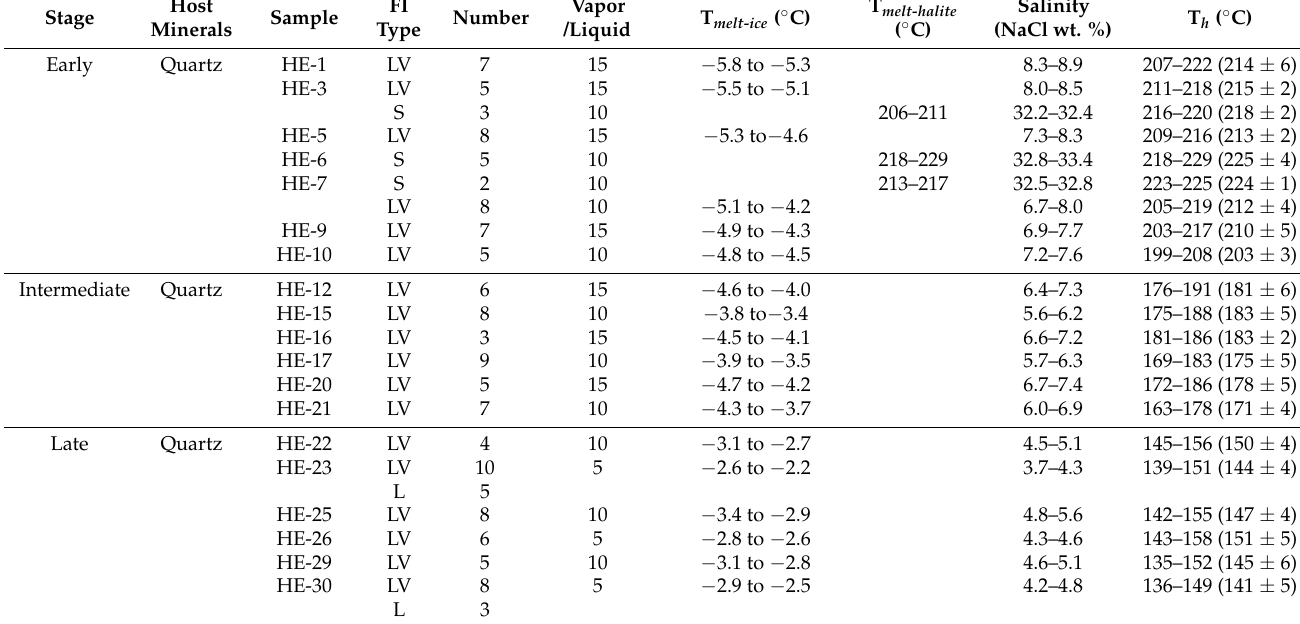
Table 1. Microthermometric data from FIs in quartz of the Harla gold